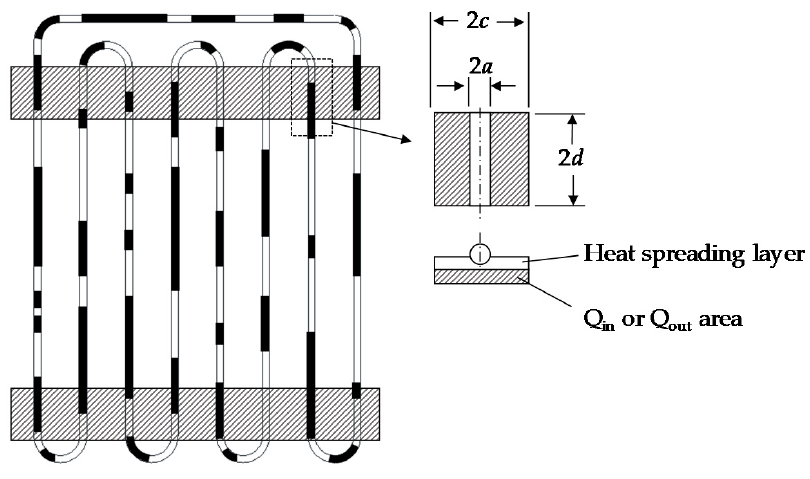
Figure 3. Schematic of simplified heat-spreading model.